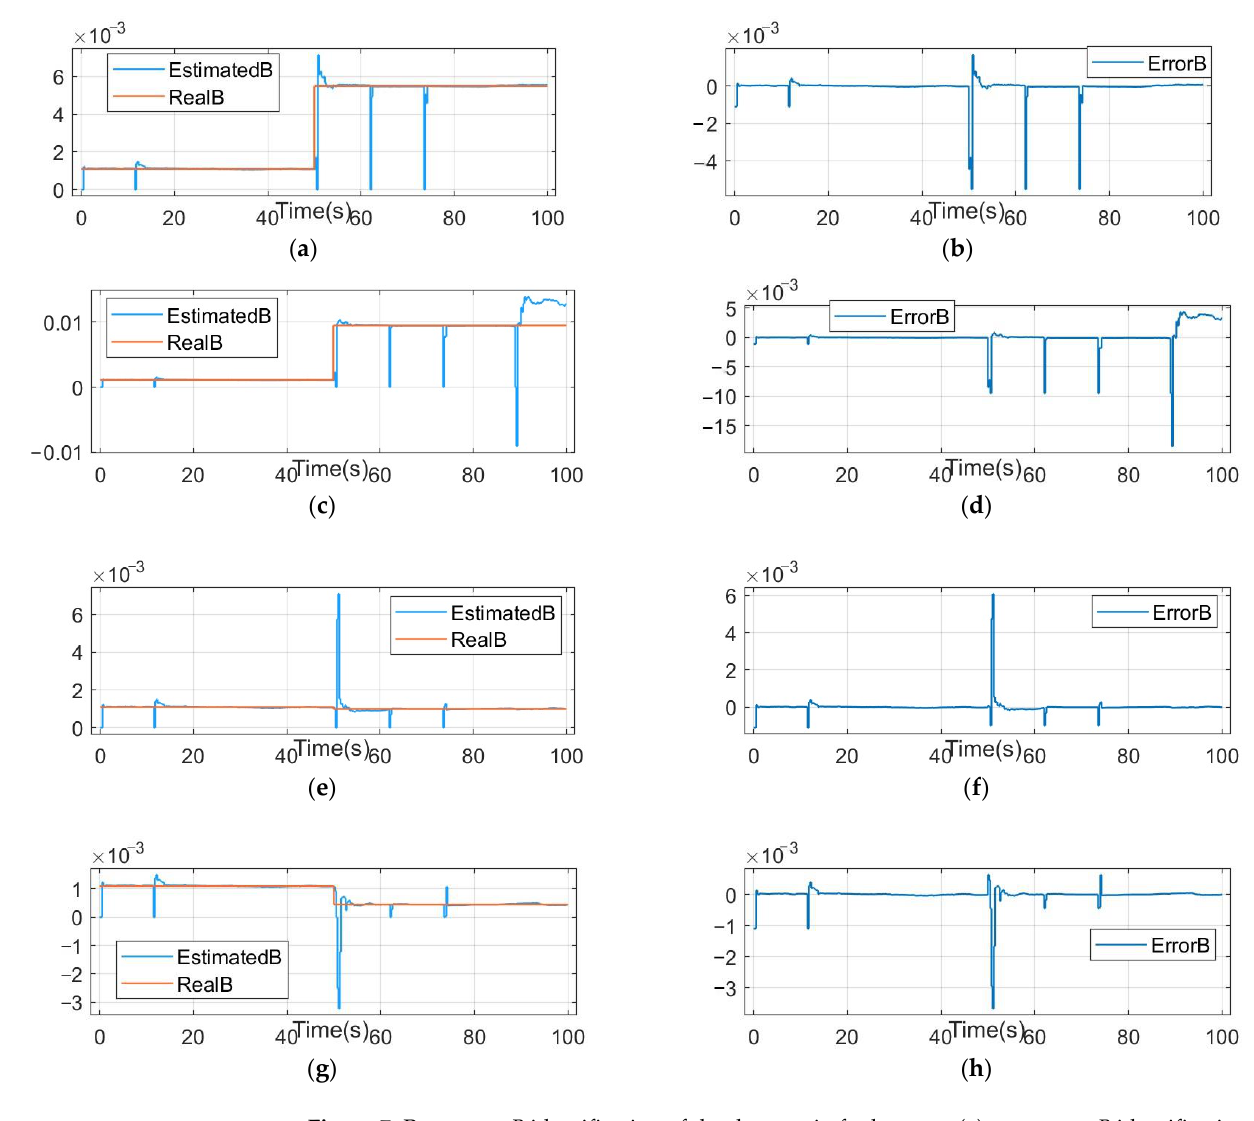
Figure 7. Parameter B identification of the thruster in fault states: ( a ) parameter B identification of a thruster with an entanglement fault; ( b ) parameter B error of a thruster with an entanglement fault; ( c ) parameter B identification of a thruster with a jamming fault; ( d ) parameter B error of thruster with jamming fault; ( e ) parameter B identification of a thruster with a breaking fault; ( f ) Parameter